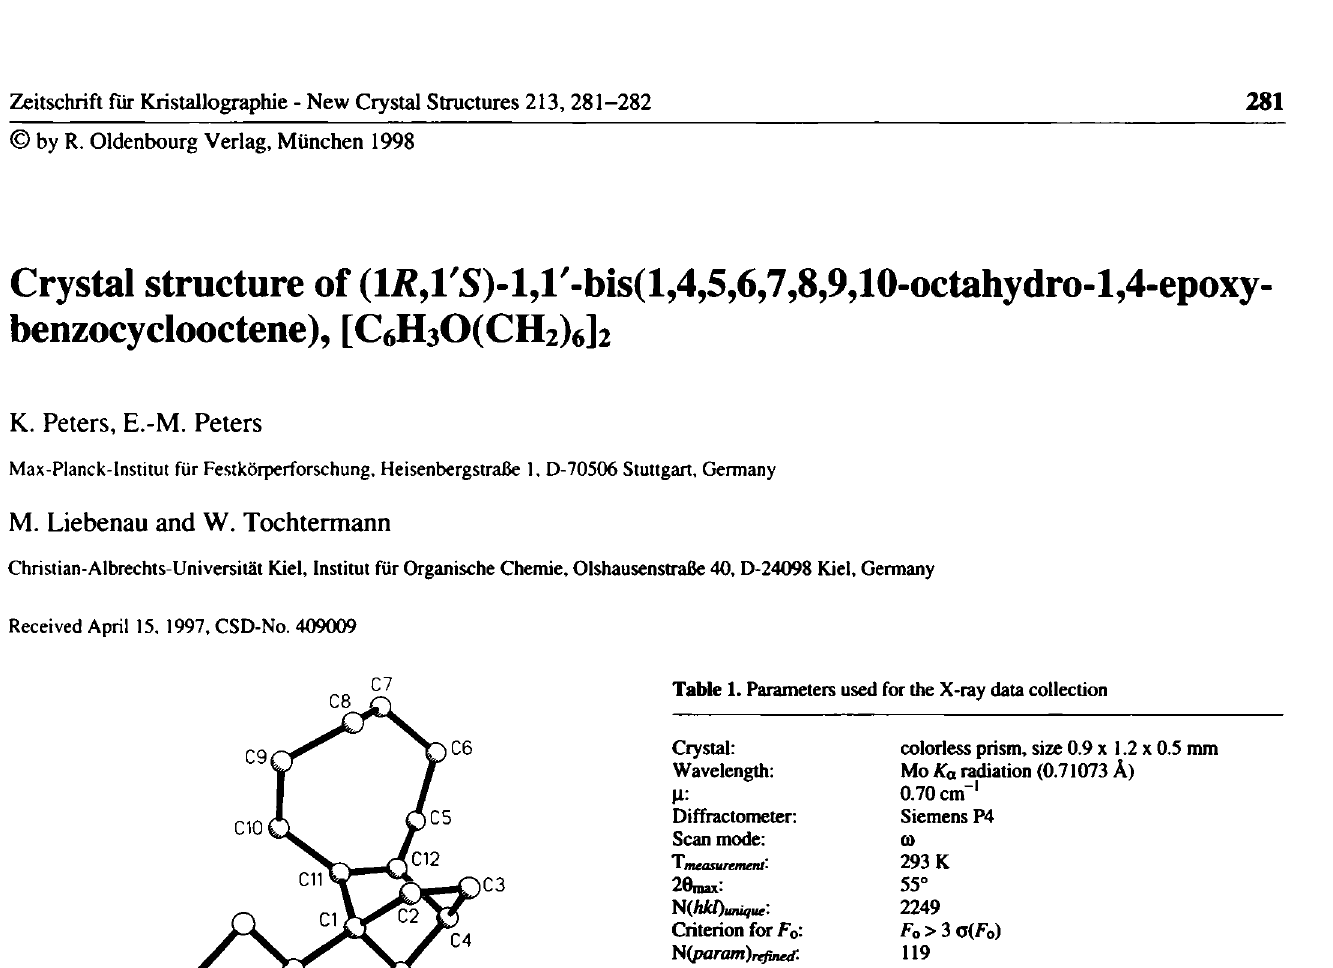
Table 2. Final atomic coordinates and displacement parameters (in Â^)